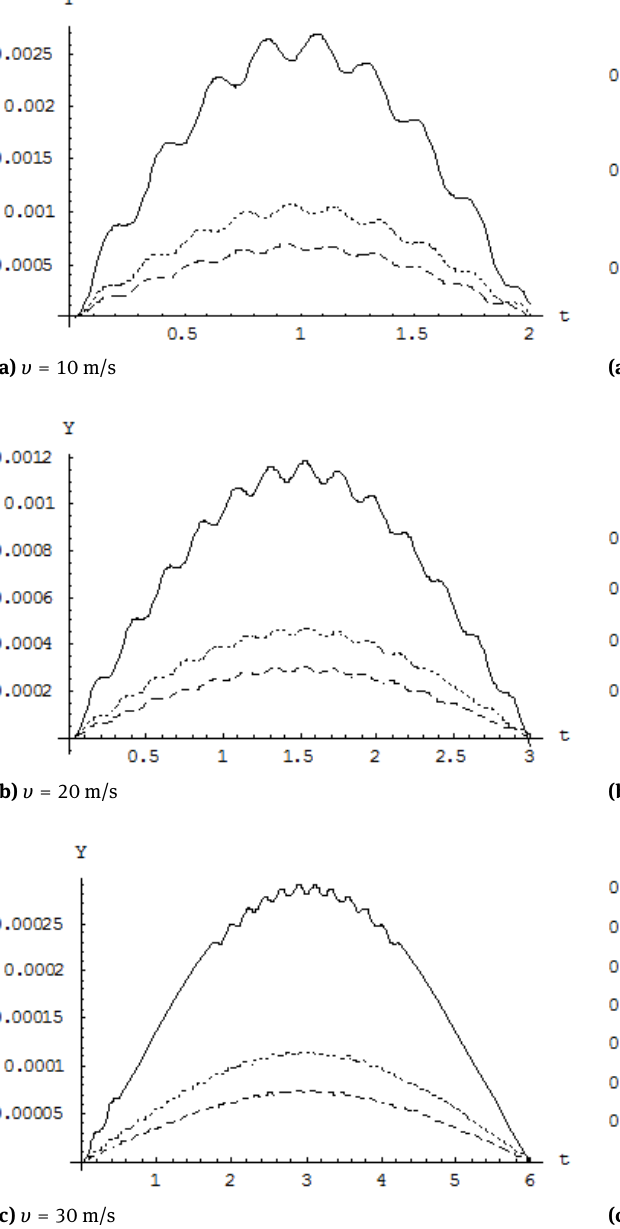
Figure 7: The influence of the eccentricity for υ = 30 m/s and vari- ous values of R : ___ e H = 3 m, ...... e H = 0 m, - - - e H = −3 m.